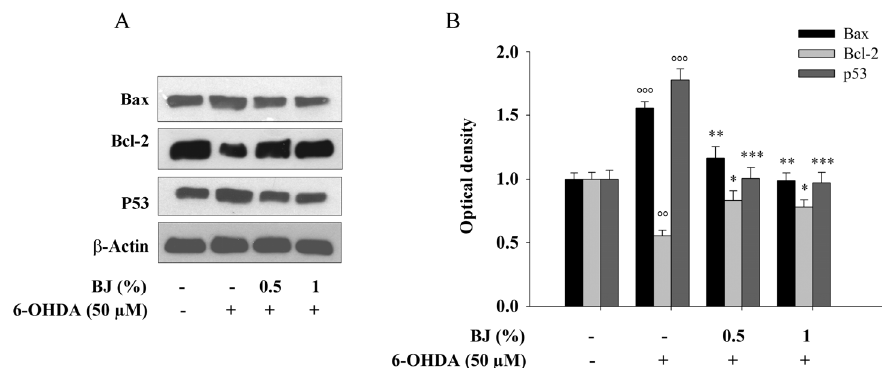
Figure 5. Protective effect of BJ on apoptotic-related proteins. SH-SY5Y cells were treated as reported above. Then, p53, Bax and Bcl-2 proteins levels were measured by western blotting. Representative immunoblots are displayed ( A ). Densitometric analysis of three independent blots (mean ± SEM) is depicted ( B ). Proteins amount were extrapolated as the values found in the untreated cells which were arbitrarily expressed as 1. °° P < 0.01 and °°° P < 0.001 vs. control cells; *, ** and *** P < 0.05, P < 0.01 and P < 0.001 vs. 6-OHDA-treated cells, respectively.